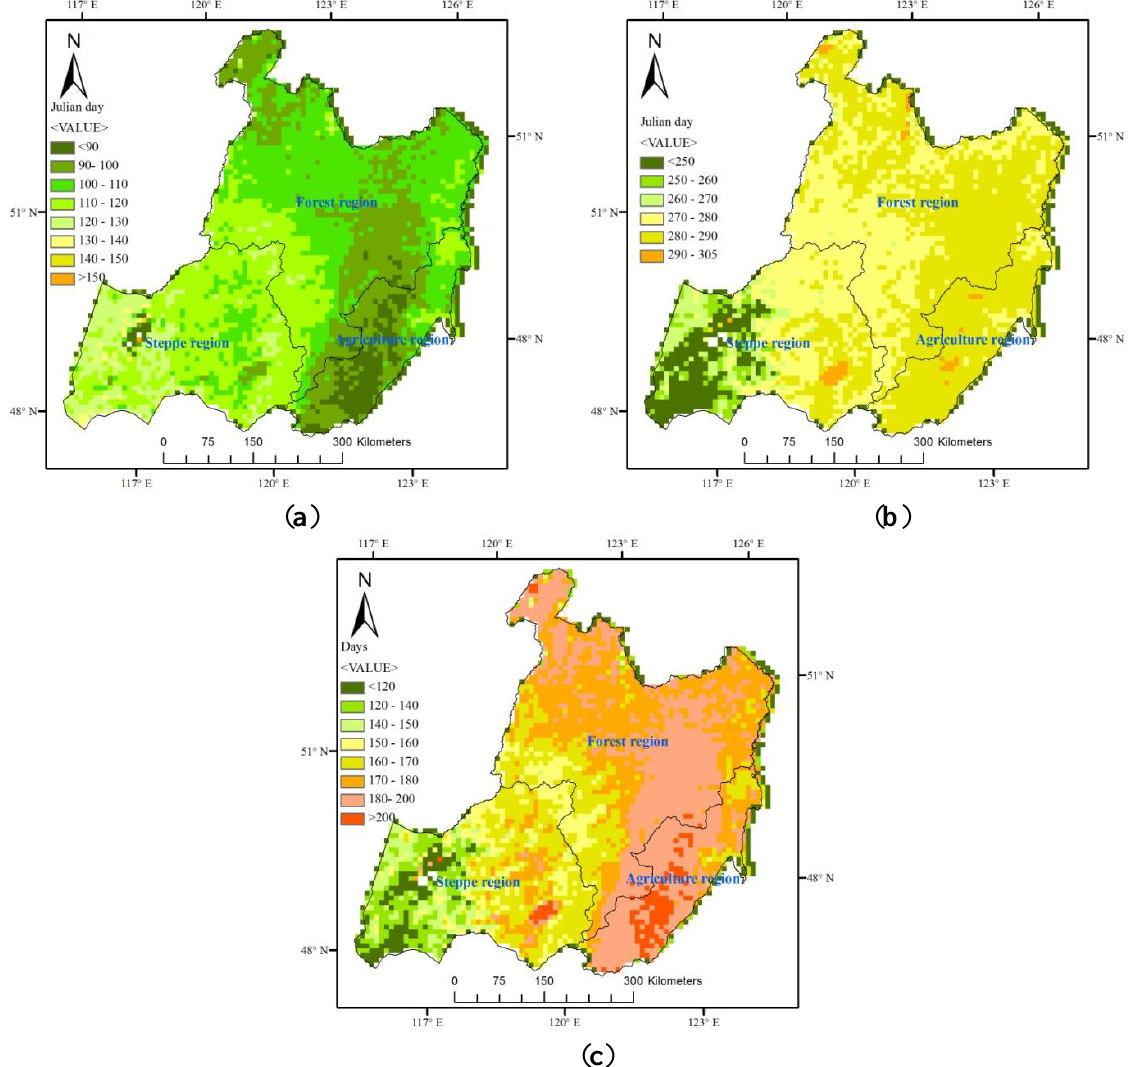
Figure 3. Spatial distribution of phenological parameters in Hulunber during the period 1982–2012. ( a ) SOS; ( b ) EOS; ( c )